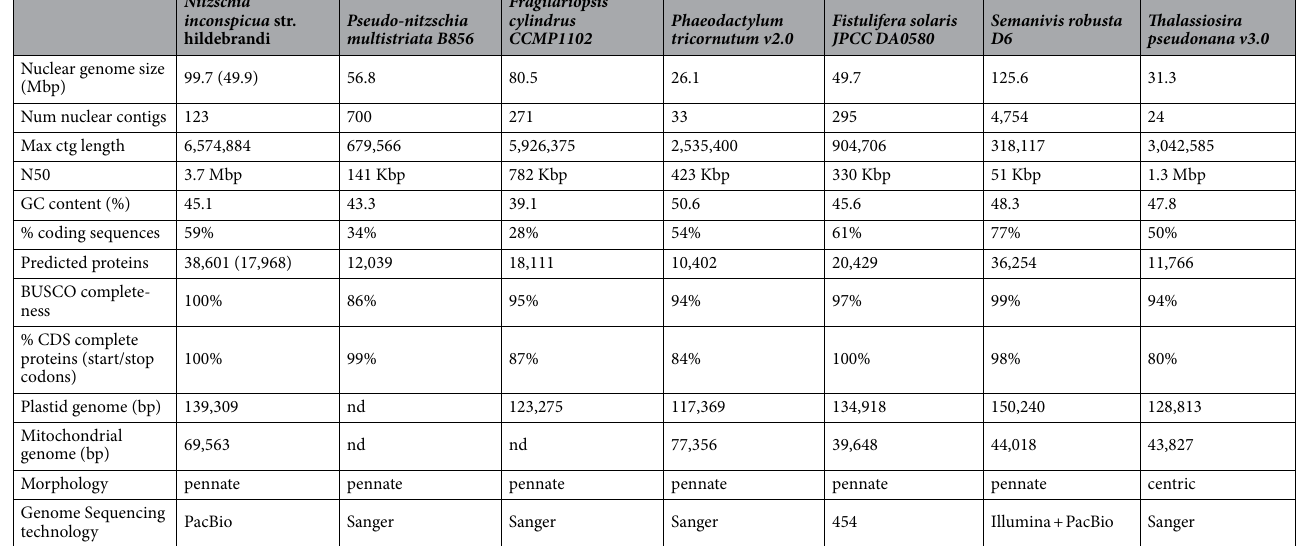
Table 1. Genomic properties of Nitzschia inconspicua str. hildebrandi and related diatoms. Genome size and number of predicted proteins shown for N. inconspicua are for the entire diploid assembly, with estimated haploid values in parentheses. The N. inconspicua haploid protein number is less than half of the diploid value because it was calculated using historical conventions typically applied to older diatom genomes, excluding allelic duplicates, alternative transcripts, and low complexity regions, as described in Materials and Methods. Additional information on BUSCO completeness scores is presented in Supplementary Table